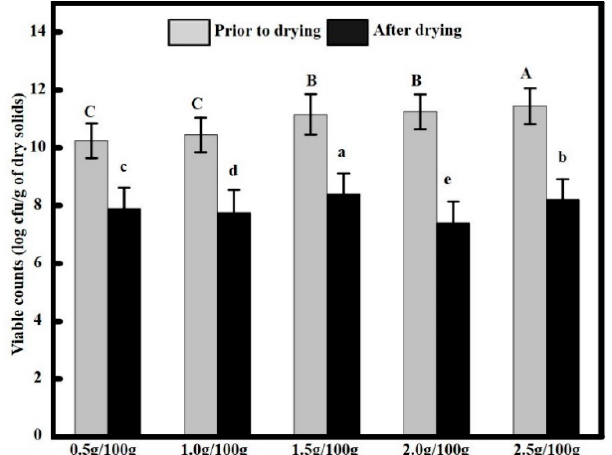
Figure 1. Survival of Lactococcus lactis throughout air drying at 30 °C for 48 h. Data followed by different capital letter are significantly different ( p < 0.05) when comparing viable counts prior to drying. Data followed by different lowercase letters are significantly different ( p < 0.05) when comparing viable counts after drying.